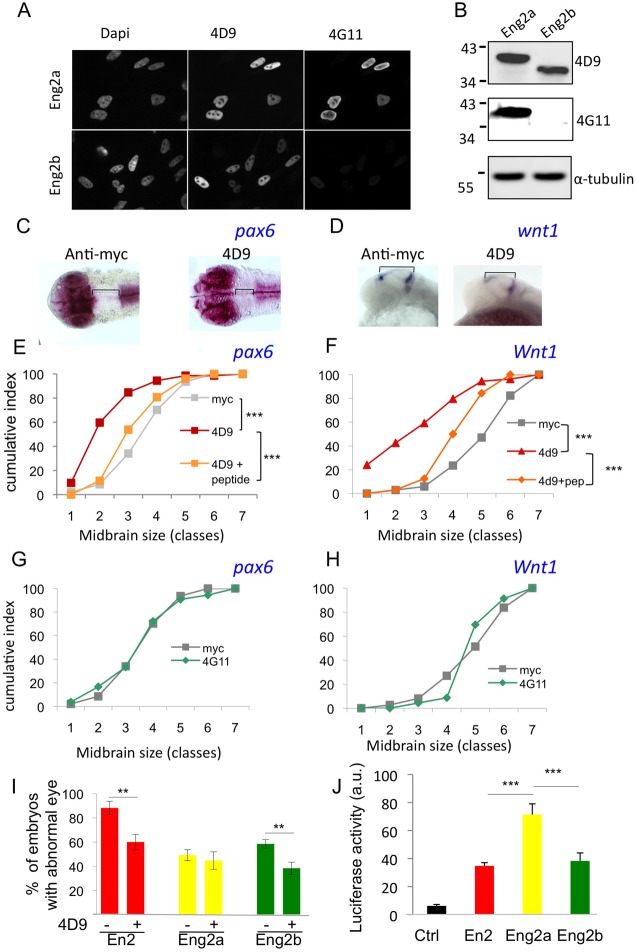
Intercellular transfer of Eng2b but not 2a is involved in DMB positioning. (A,B) Co-detection of Eng2 proteins with FITC-labelled 4D9 and TRITC-labelled 4G11 antibodies by immunohistochemistry (A) or western blot analysis on HeLa cells (B). Using both techniques, 4D9 recognised Eng2a and Eng2b, whereas 4G11 recognised only Eng2a. (C-H) Paracrine activity of endogenous En2 proteins. Zebrafish embryos were injected in the intercellular space at blastula stage with anti-myc or anti-Engrailed (4G11 or 4D9) antibody. Mesencephalon length was quantified by pax6 (C,E,G) or wnt1 (D,F,H) in situ hybridisation. Representative in situ hybridisation staining of pax6 (dorsal view) (C) and wnt1 (lateral view) (D). Measurements were distributed into seven size classes (smallest size, class 1) and plotted as cumulative frequency index. 4D9 extracellular injection induced mesencephalon shortening (E,F) in a dose-dependent manner (supplementary material Fig. S4), which was the case for neither anti-myc (E-H) nor 4G11 injection (G,H). Co-injection of the 4D9 antibody with its epitope peptide (pep) significantly reduced this effect (E,F). ***P<0.0001, Mann–Whitney tests. (I) Inhibition of homeoprotein transfer rescued the phenotype of Eng2b activation but not of Eng2a. Zebrafish embryos were injected at the one-cell stage with the indicated mRNAs and injected again in the extracellular space at the blastula stage with 4D9 anti-En antibody. CYC was added at 50% epiboly in the water bath to activate the protein. Eye phenotypes were scored at 2 dpf. The error bars represent statistical errors. (J) Transcriptional activity of En2 and the two zebrafish Eng2. The MAP1B:luciferase reporter plasmid was transfected into HeLa cells along with an empty vector (Ctrl) or together with the indicated constructs, and cells were analysed for luciferase activity after 24 h. a.u., arbitrary units. **P<0.01, ***P<0.001.